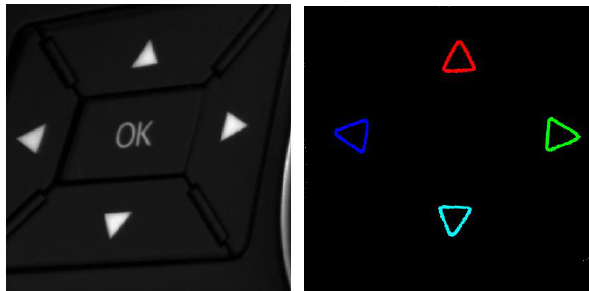
Figure 3. Creating a shape-model from reference image. Left: image containing a field of multifunctional buttons. Right: extracted contours of created shape-model